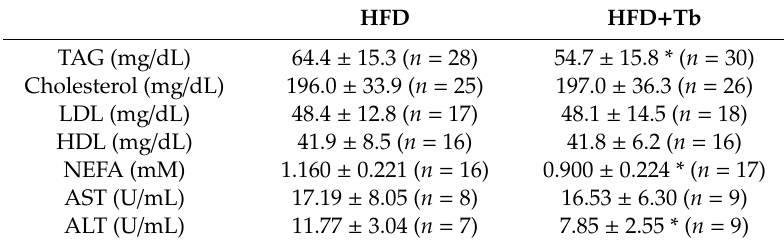
Data are presented as mean ± SD. * p < 0.05 HFD vs. HFD + Tb, Student’s t